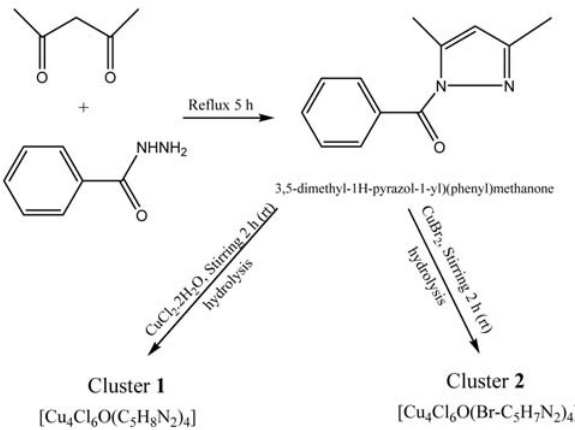
Table 2. Selected bond lengths (Å) and angles (°) in complexes 1 and 2 a